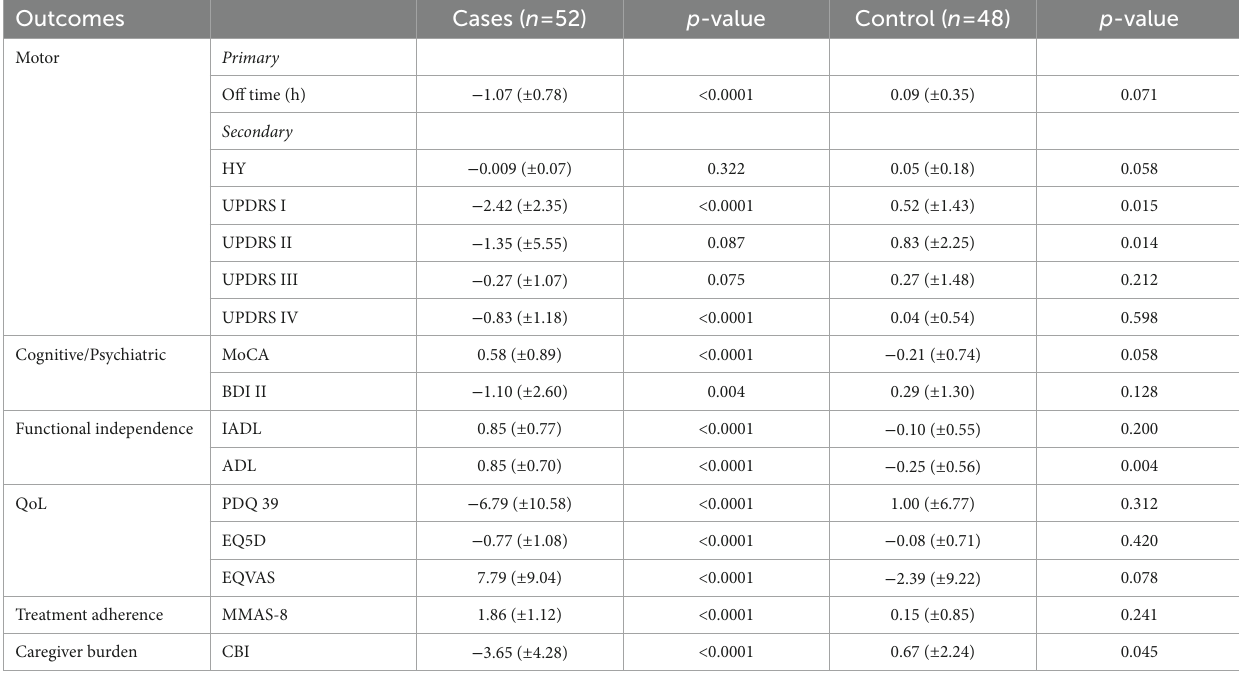
TABLE 3 Baseline and EoS outcome measures for all participants and comparison within groups.